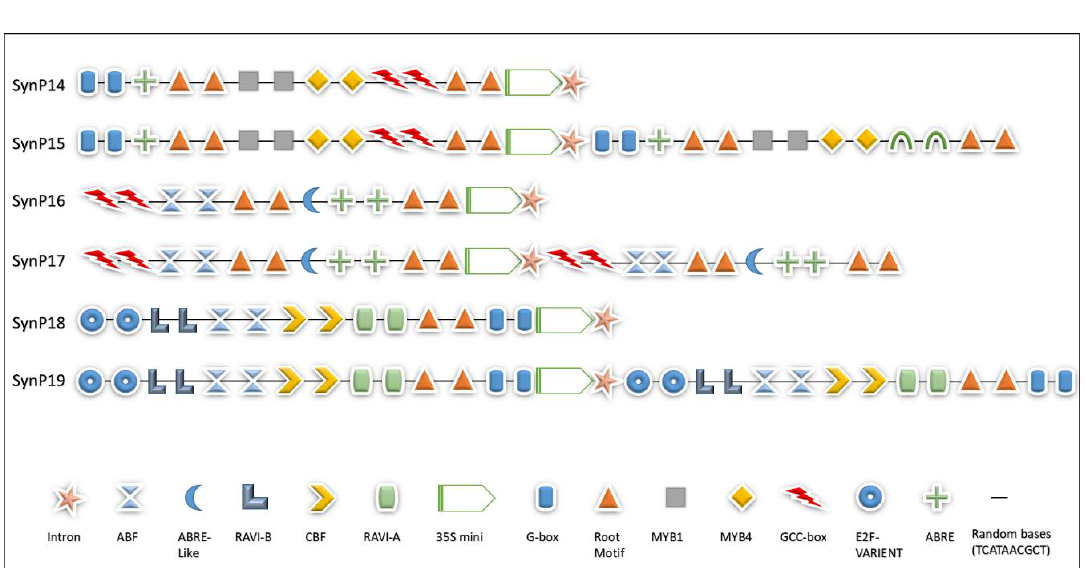
Figure 3. Empirical design of synthetic assemblies. All six promoters (SynP14–SynP19) comprised of 11 multiple cis motifs (colored shapes) spaced by random bases (black line) and a root motif. SynP14 contained multiple drought-inducible cis motifs upstream of 35S minimal promoter while SynP15 contained same synthetic module both at the upstream and downstream of 35S minimal promoter region. SynP16 contained another set of drought-inducible cis motifs. SynP17 contained same synthetic module both at upstream and downstream of the 35S minimal promoter region. SynP18 is the third set of cis motifs active against drought stress. Synp19 contained same synthetic module both at the upstream and downstream of 35S minimal promoter